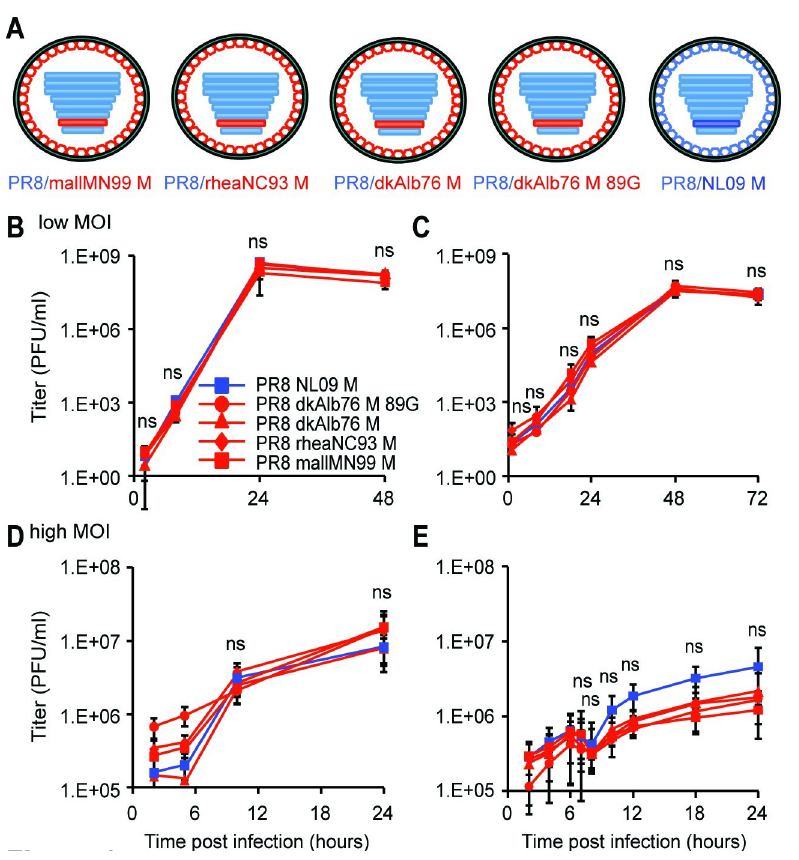
Fig 1. pH1N1 M segment does not confer improved growth relative to avian M segment in avian cells at 37˚C. (A) A panel of PR8-based viruses was rescued by reverse genetics. The viruses differ only in the identity of the M segment, which were derived from A/mallard/MN/99 (H3N8), A/rhea/NC/93 (H7N1), A/duck/Alberta/76 (H1N1), or A/NL/ 602/09 (H1N1) viruses. (B) 11-day-old embryonated chicken eggs (ECE) or ( C ) chicken DF-1 cells were infected at low MOI with the indicated viruses. (D) Quail QT-6 cells or (E) DF-1 cells were infected at a high MOI of 5 PFU/cell with the indicated viruses. In all avian systems assessed, the pH1N1 M segment did not confer an increase in magnitude or kinetics of growth, relative to any avian-origin M segment. Multi-cycle and single-cycle growth were assessed in three independent experiments, with three technical replicates per experiment. Graphs show the means with SD for the three experiments. Statistical significance was determined using repeated measures, two-way, multiple ANOVA on log-transformed values, with Bonferroni correction applied to account for comparison of a limited number of